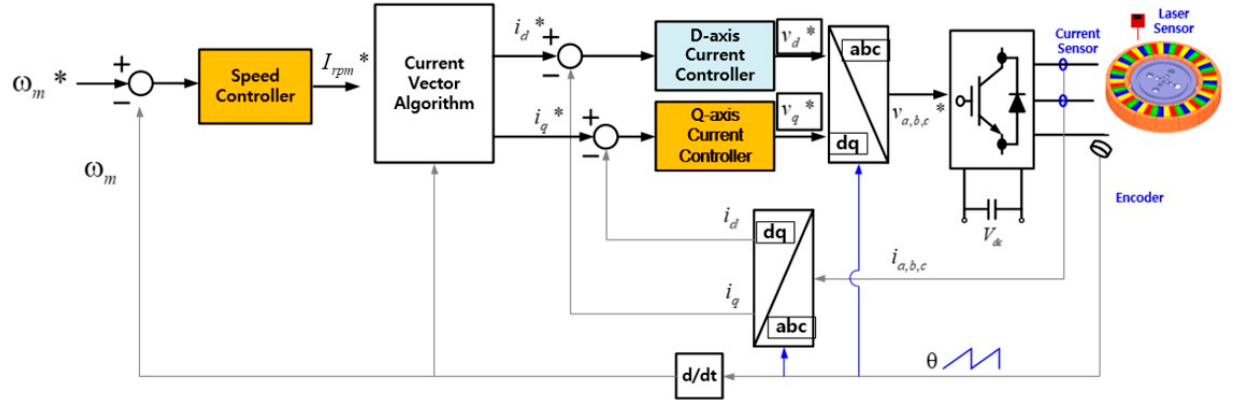
Figure 9. Control block diagram for the rotation (* is command value).